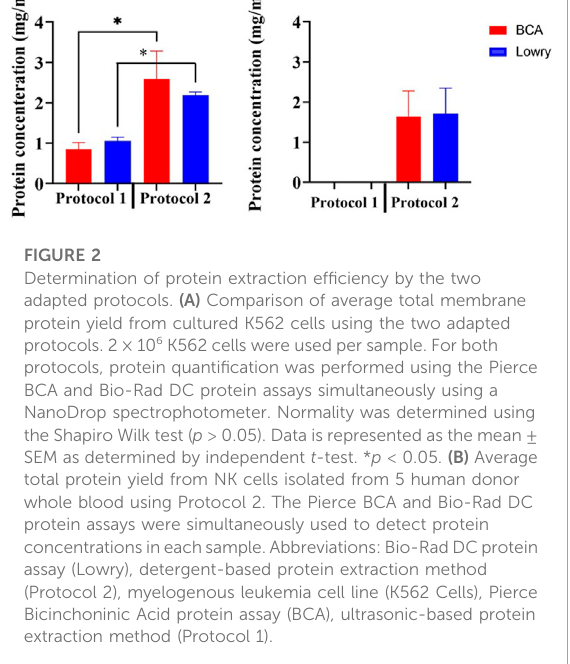
Protocol 2. Average NK cell purity was ≥ 90% (Gating strategy